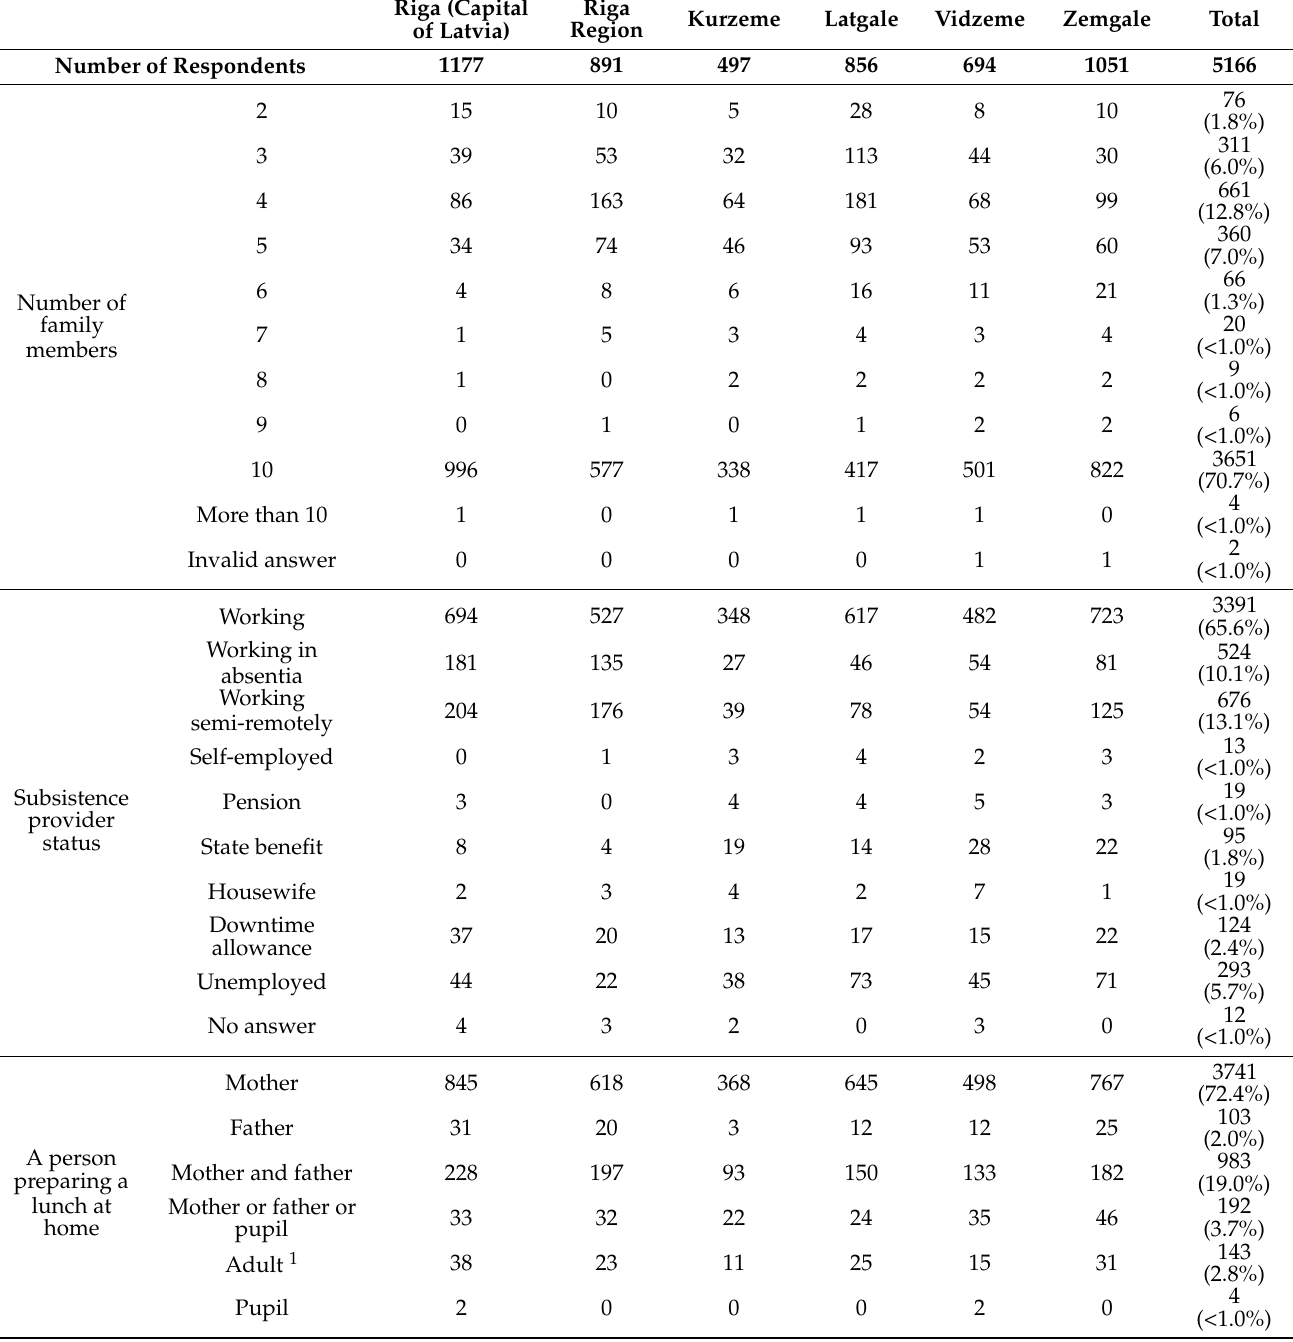
Table 1. Profile of